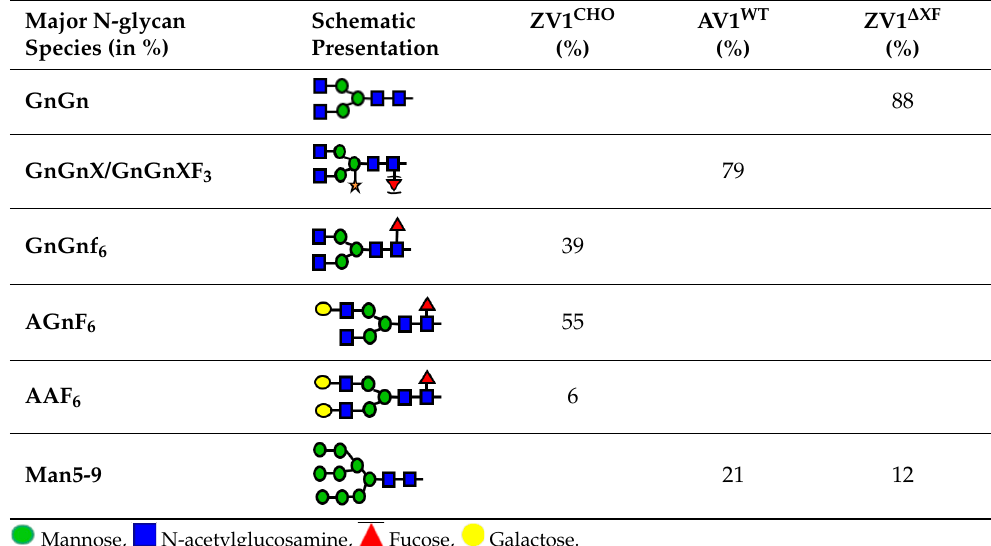
Table 1. N-glycosylation characterization of ZV1 variants.